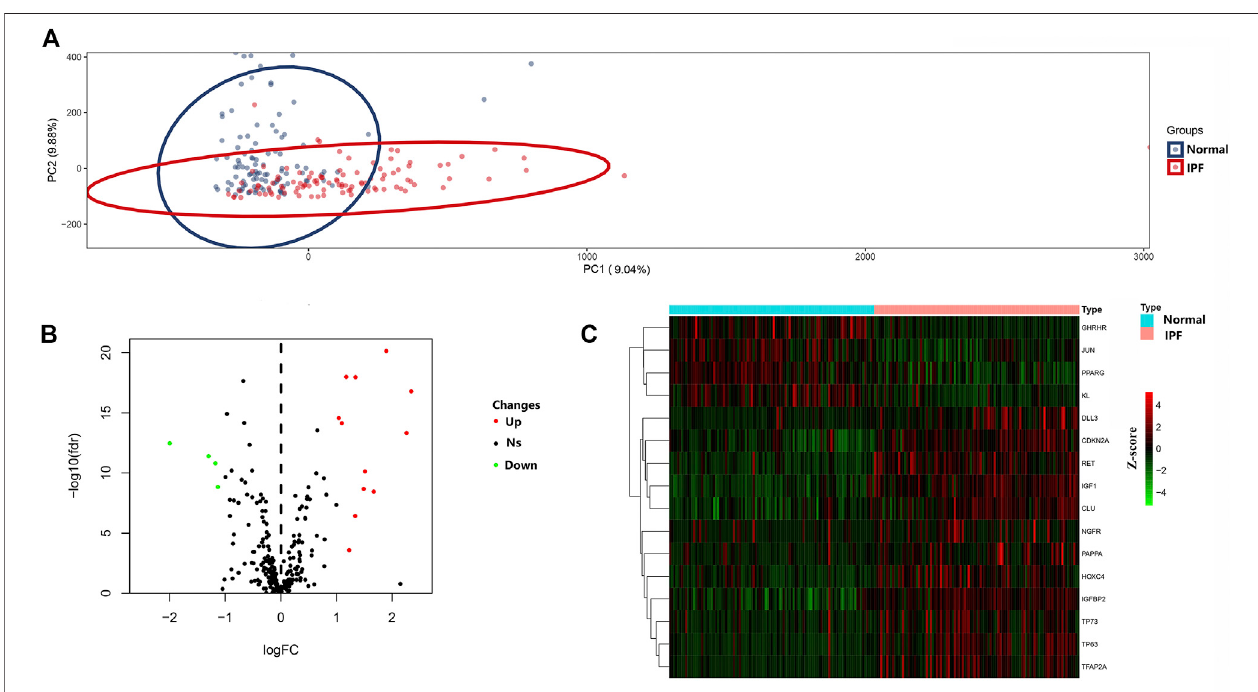
FIGURE 1 | Differential expressed aging-related genes in IPF and healthy samples. (A) Principal component analysis for GSE150910. (B) Volcano of the 307 differentially expressed aging-related genes. The red dots represent the signi fi cantly up-regulated genes and the blue suggest the signi fi cantly down-regulated genes. (C) Heatmap of the 16 differentially expressed aging-related genes in IPF and healthy